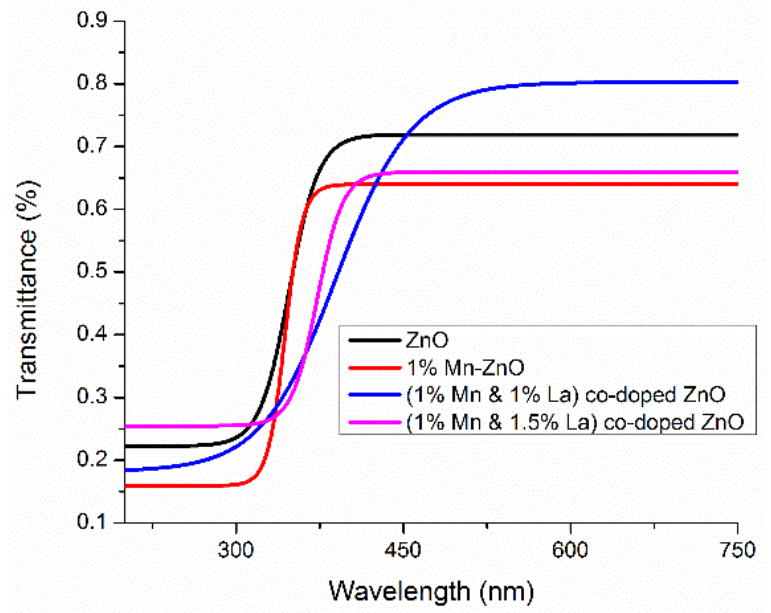
Figure 7. Transmittance of undoped ZnO films and ZnO films co-doped with Mn and La.